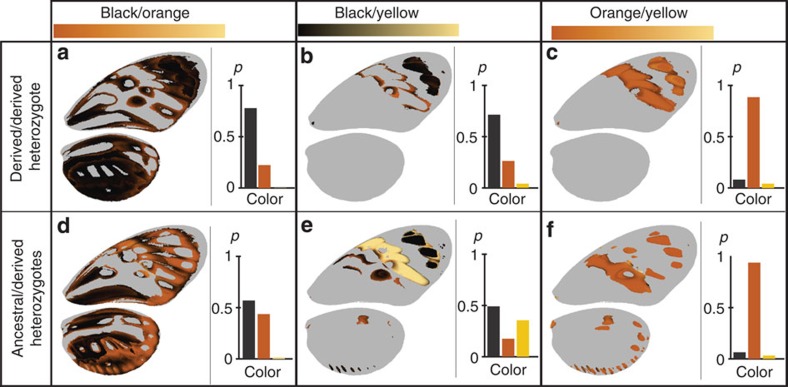
Colour hierarchy maps.These maps report, pixel-by-pixel, the proportion of heterozygous individuals expressing black, orange or yellow where their corresponding homozygotes express distinct colours. For visualization purposes, these proportions are translated into gradients of black, orange and yellow. Grey represents areas where no variation was observed for the corresponding pair of colour in homozygous genotype. For each pair of colour the probability of expressing each of the three colours over all pixels is summarized by a bar chart to the right of each map. Maps and bar charts calculated for: black/orange on the first column (a,d); black/yellow on the second column (b,e); orange/yellow on the third column (c,f). Colour hierarchy maps of derived/derived heterozygotes are represented on the first line, and the ones of ancestral/derived heterozygotes on the second line.